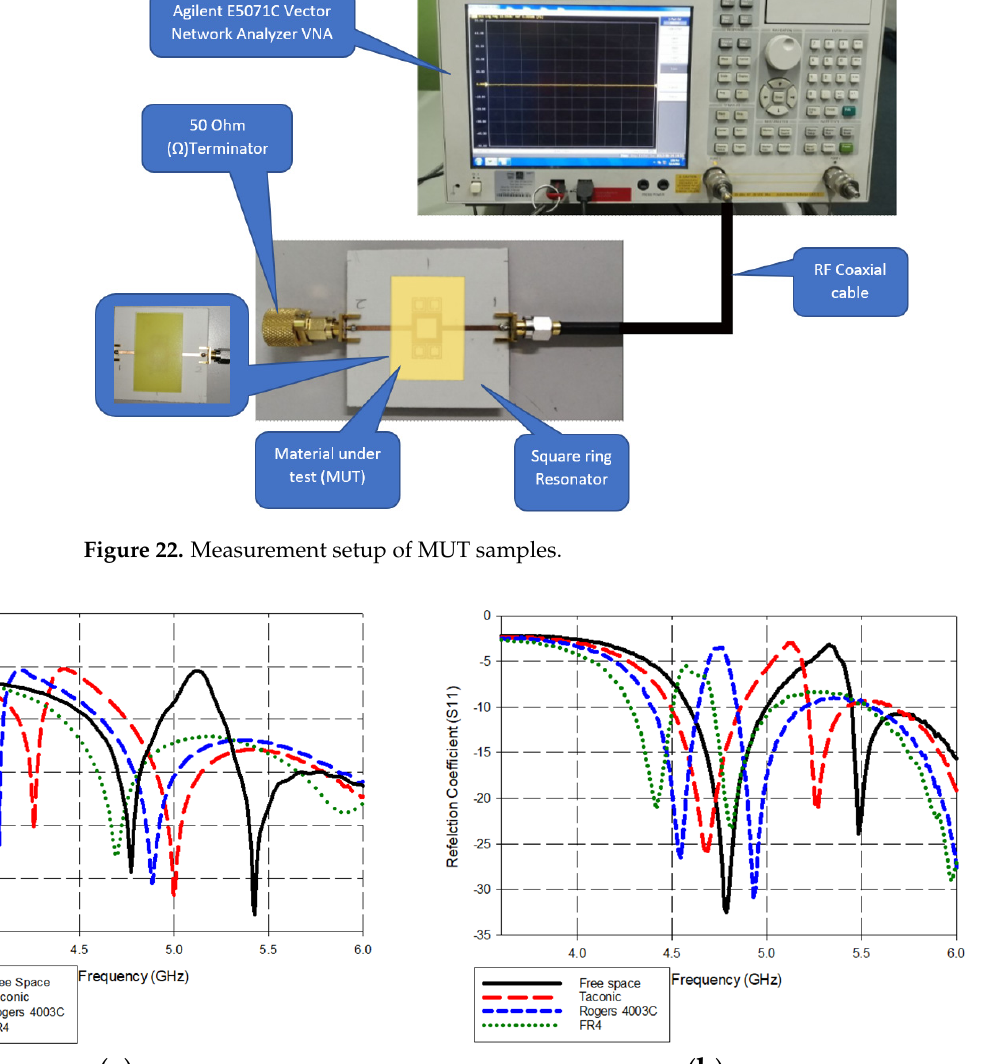
Figure 22. Measurement setup of MUT samples. Table 4. MUT samples and their dimensions.